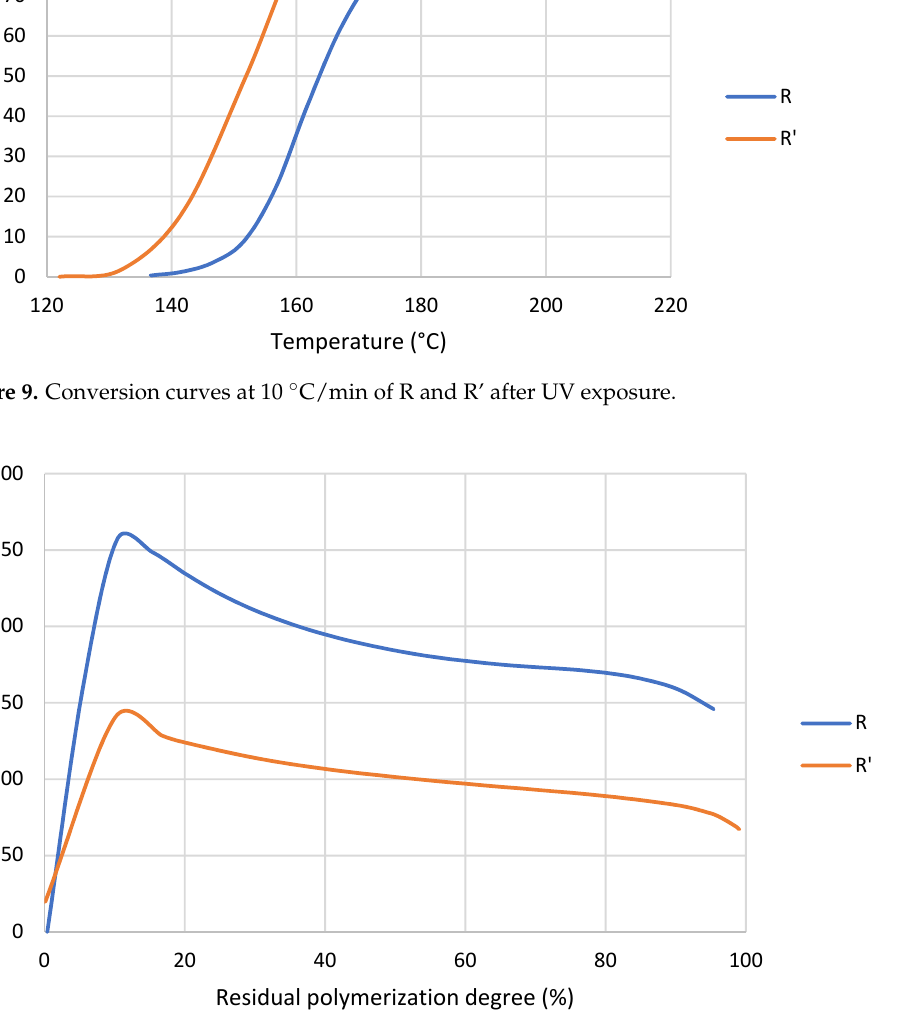
Figure 10. Activation energy as a function of residual conversion degree of R and R’ after UV exposure obtained by MFK model.